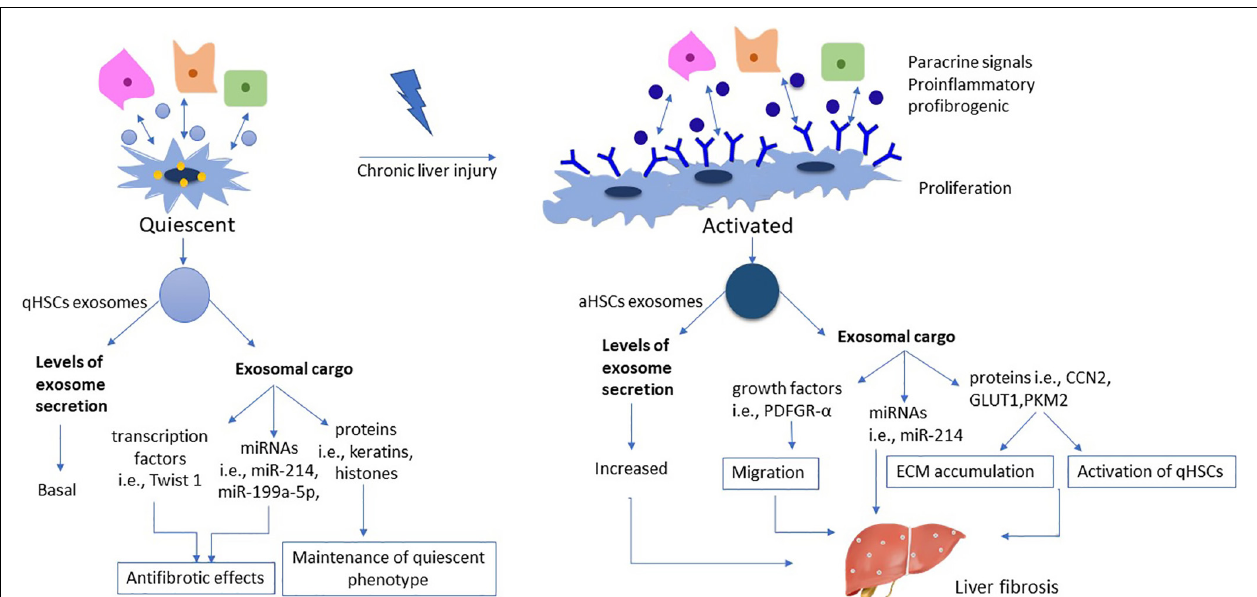
FIGURE 2 | Role of exosomes during HSC activation. The number of exosomes derived from qHSCs is on basal levels, reflecting their metabolic phenotype as resting, vitamin A storing cells. Exosomal cargo includes various transcription factors (i.e., Twist 1) miRNAs (i.e., miR-214, miR-199a-5p) and proteins (i.e., keratins, histones), all being associated with antifibrotic properties and maintaining a dynamic balance in qHSCs phenotype. On the other hand, aHSCs are characterized by increased exosome secretion reflecting the phenotypical transformation into highly proliferative myofibroblastic cells. On this context, the cargo encapsulated in aHSCs exosomes consists of growth factors (i.e., PDGFR- α ), miRNAs (i.e., miR-214) and proteins (i.e., CCN2, GLUT1, PKM2), all being associated with further activation of qHSCs and propagation of the fibrotic